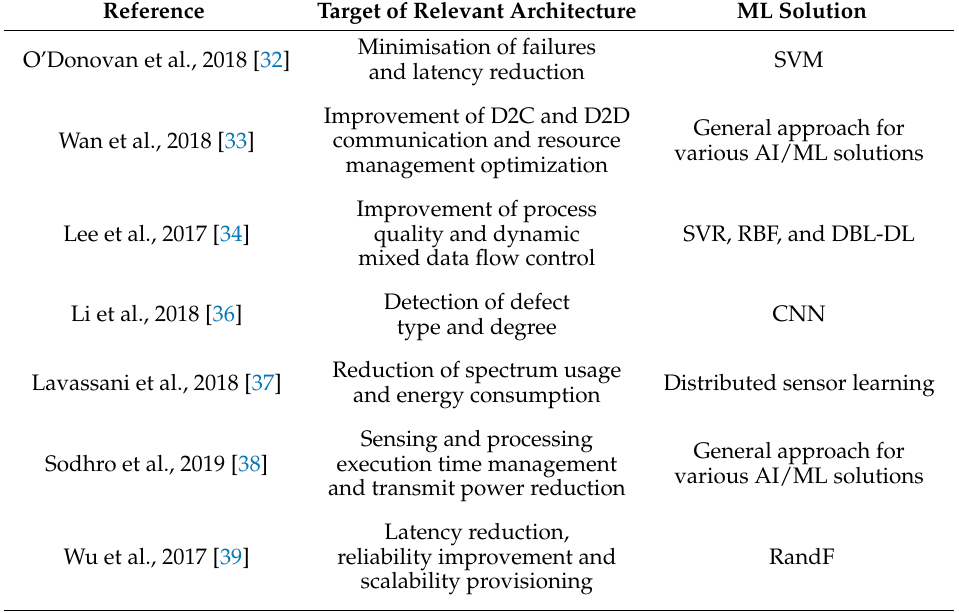
Table 2. Target of cloud/fog/edge architectures and respective ML solutions for Industry